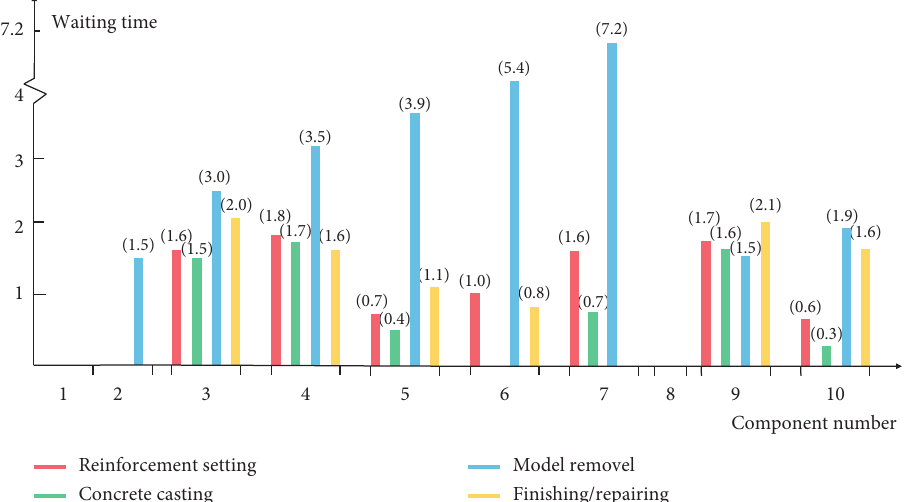
Figure 7: Waiting time chart for scheme